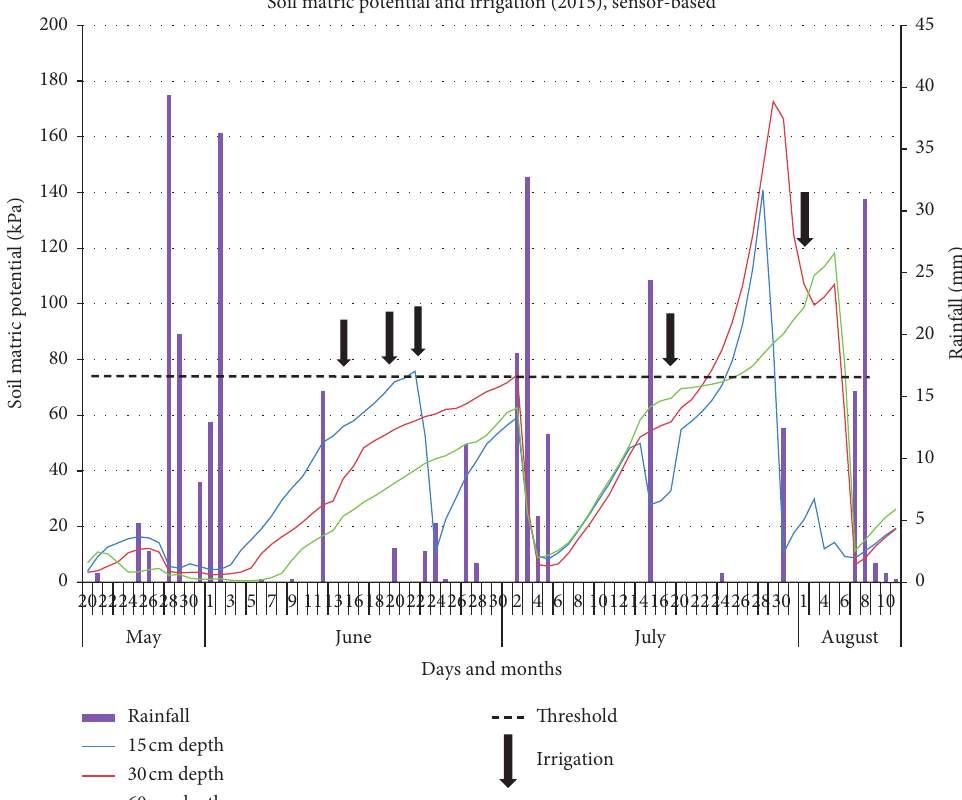
Figure 3: Daily soil matric potential in the sensor-based plot fertilized with 269kg N ha − 1 in 2015 at TVREC. The amount of irrigation referred to in the black arrows was value between 15 and 25 mm to avoid